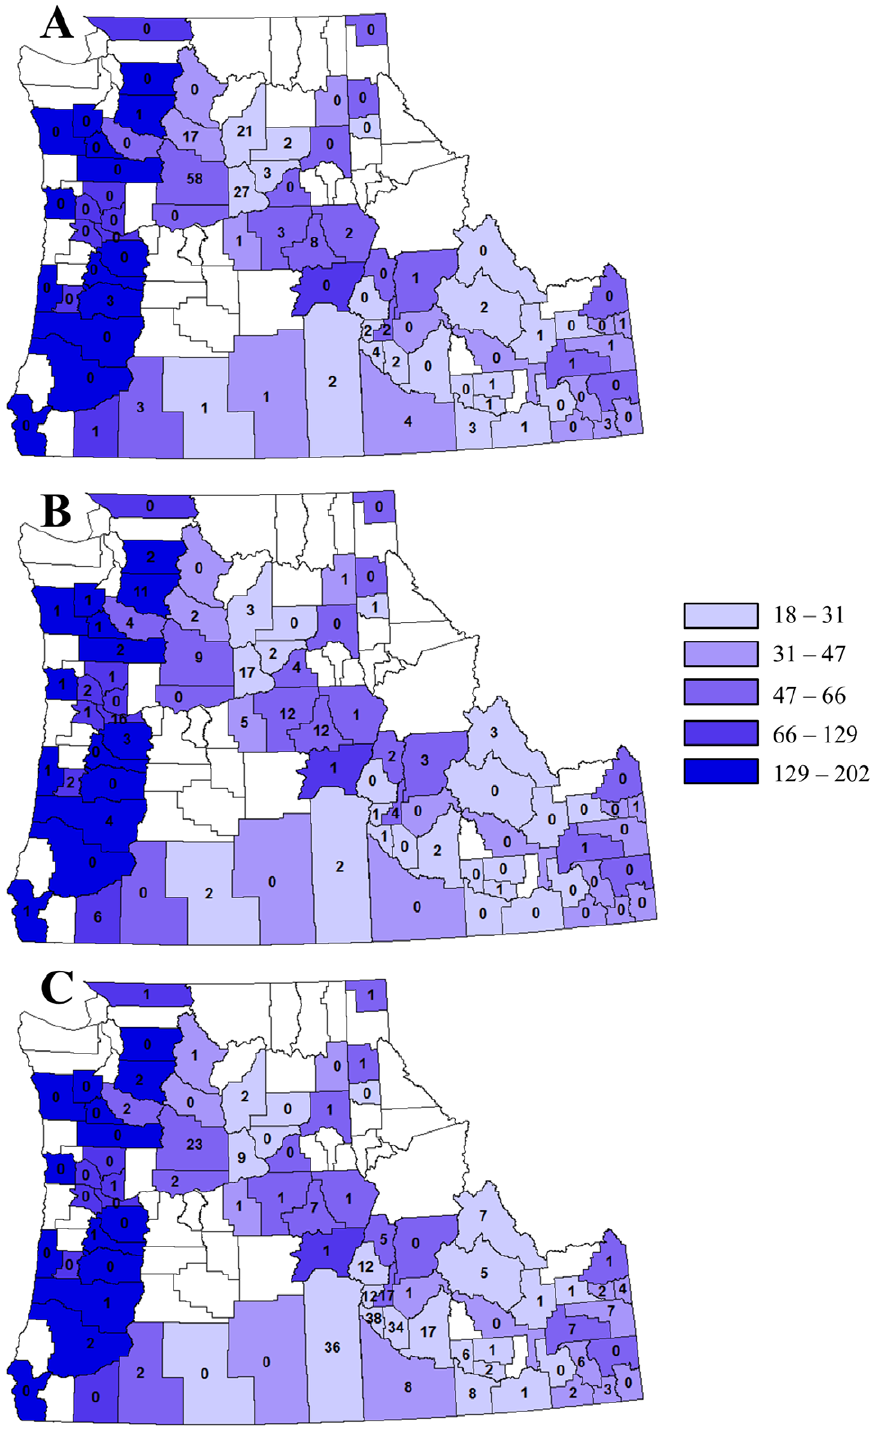
Figure 2. Precipitation and the prevalence of West Nile virus infection. Number of West Nile virus (WNV) infections in (A) horses, (B) birds, and (C) humans from 2007 to 2010 over Idaho, Oregon, and Washington States. Counties are shaded according to their annual average precipitation (mm, only counties where WNV was detected in any species are shaded), with the numbers indicating the number of infections in each organism(s). doi:10.1371/journal.pone.0055006.g002 orchard habitats produced local focal points that promoted vector- produce focal points for WNV infection. In contrast, more host contact and subsequent pathogen transmission across landscapes, supporting the hypothesis that local processes strongly impact WNV infections across landscapes [10]. prevalence of WNV across landscapes (Fig. 3). This suggests that